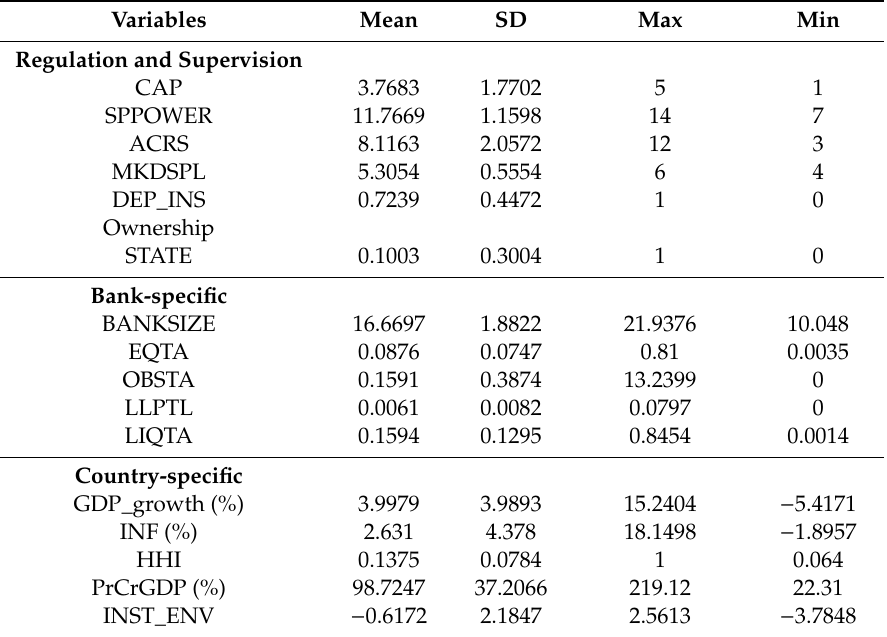
Table 3. Descriptive statistics of regression model variables (2005–2014).